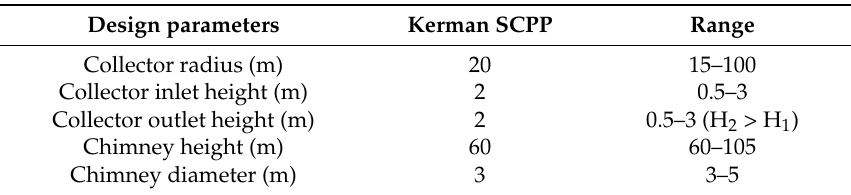
Table 1. Design parameters for Kerman power plant and their acceptable